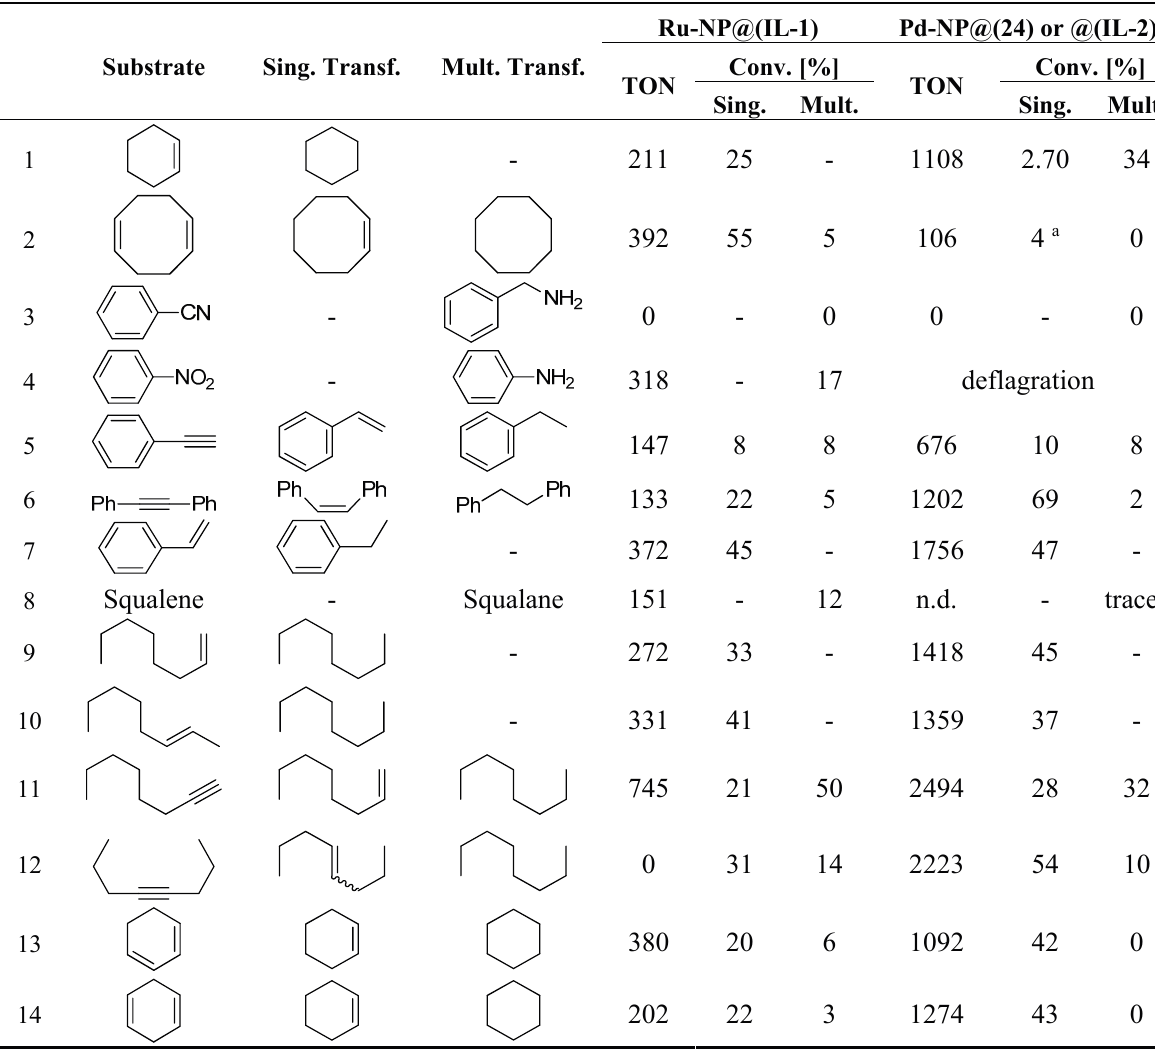
Table 4. Comparison between Ru-NPs and